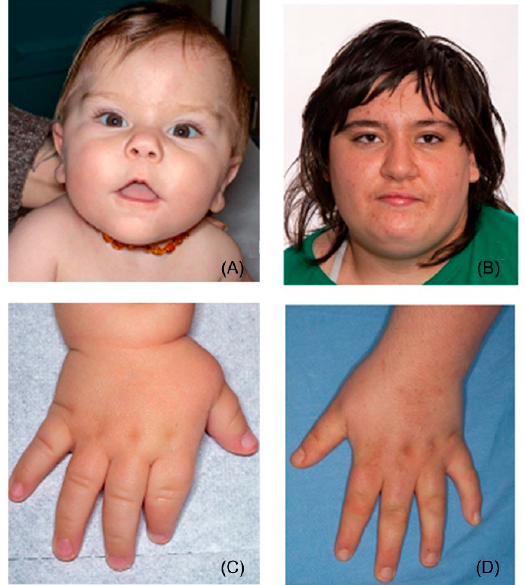
Figure 1. Main clinical anomalies in SMS: Classic facial phenotype in child ( A ) and in adolescence ( B ). Typical small hand with brachydactyly ( C , D ). ( B ). Typical small hand with brachydactyly ( C , D